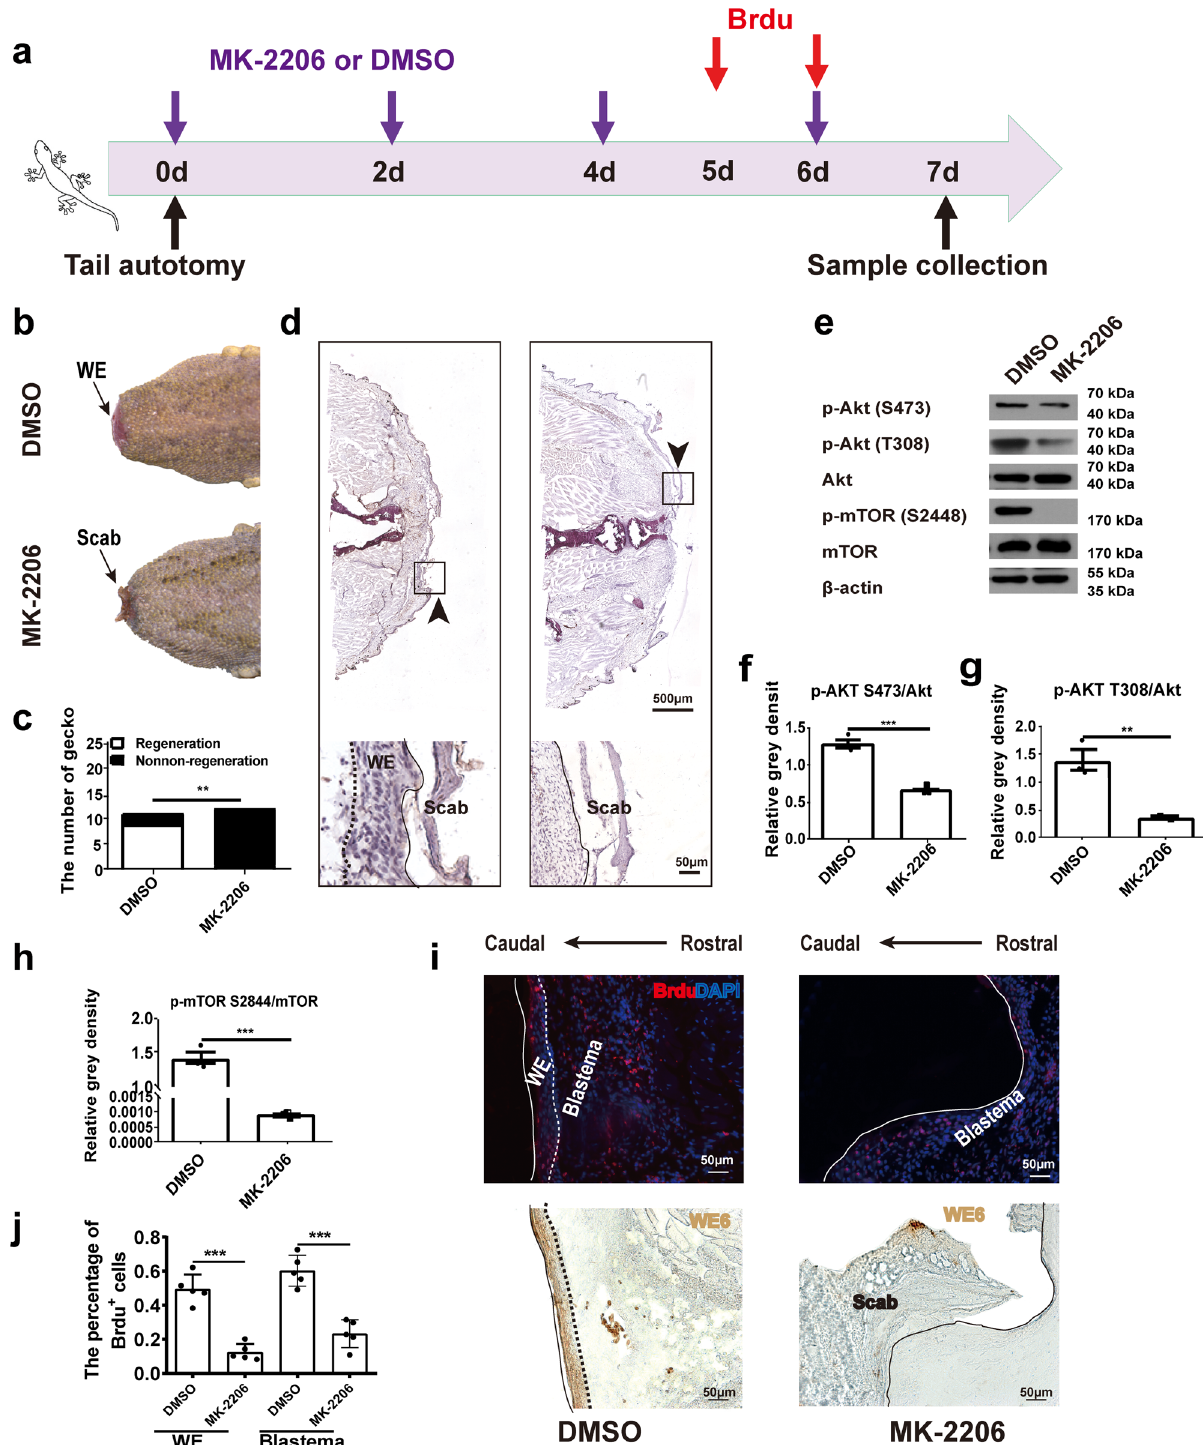
Fig. 3 Akt blocking lowered the proliferation of wound epithelium. a The schematic picture of timeline for drug delivering and sample collection. b Formation of wound epithelium (WE) in geckos in the control (DMSO) and Akt inhibition groups (MK-2206). c Number of geckos with regeneration in control and Akt inhibition groups. N = 10 for each group. d H&E staining of tail tissues from control and Akt inhibition groups. Solid arrow indicates the injury site, dashed box indicates the magni fi ed area, dotted line indicates border between wound epithelium and scab, and solid line indicates junction between rostral end of wound epithelium and blastema. Scale bar = 500 µ m or 50 µ m. N = 3. e Protein levels of p-Akt (Ser473, Thr308), Akt, p-mTOR (Ser2448), and mTOR in tail tissues. f – h Relative level of p-Akt (Ser473)/Akt, p-Akt (Thr308)/Akt, and p-mTOR (Ser2448)/mTOR in Fig. 3d. N = 3. i Immuno fl uorescence analysis of BrdU staining in control (DMSO) and Akt inhibition group (MK-2206) (upper panel). Immunohistochemistry analysis of WE6 staining of the same location of the samples. Solid line indicates the caudal border of wound epithelium, dotted line indicates border between wound epithelium and blastema. Scale bar = 50 µ m. j Number of BrdU positive cells in control and Akt inhibition group. Values represent mean ± SD, N = 5, ns p > 0.05, * p < 0.05, ** p < 0.01, *** p < 0.001. COMMUNICATIONS BIOLOGY| (2022) 5:1018